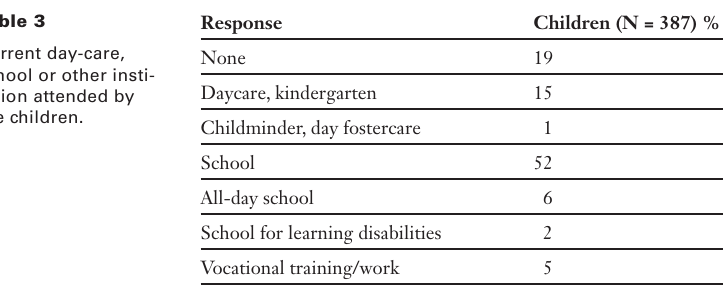
Who is the main per- son responsible for caring for and look- ing after your child/children?